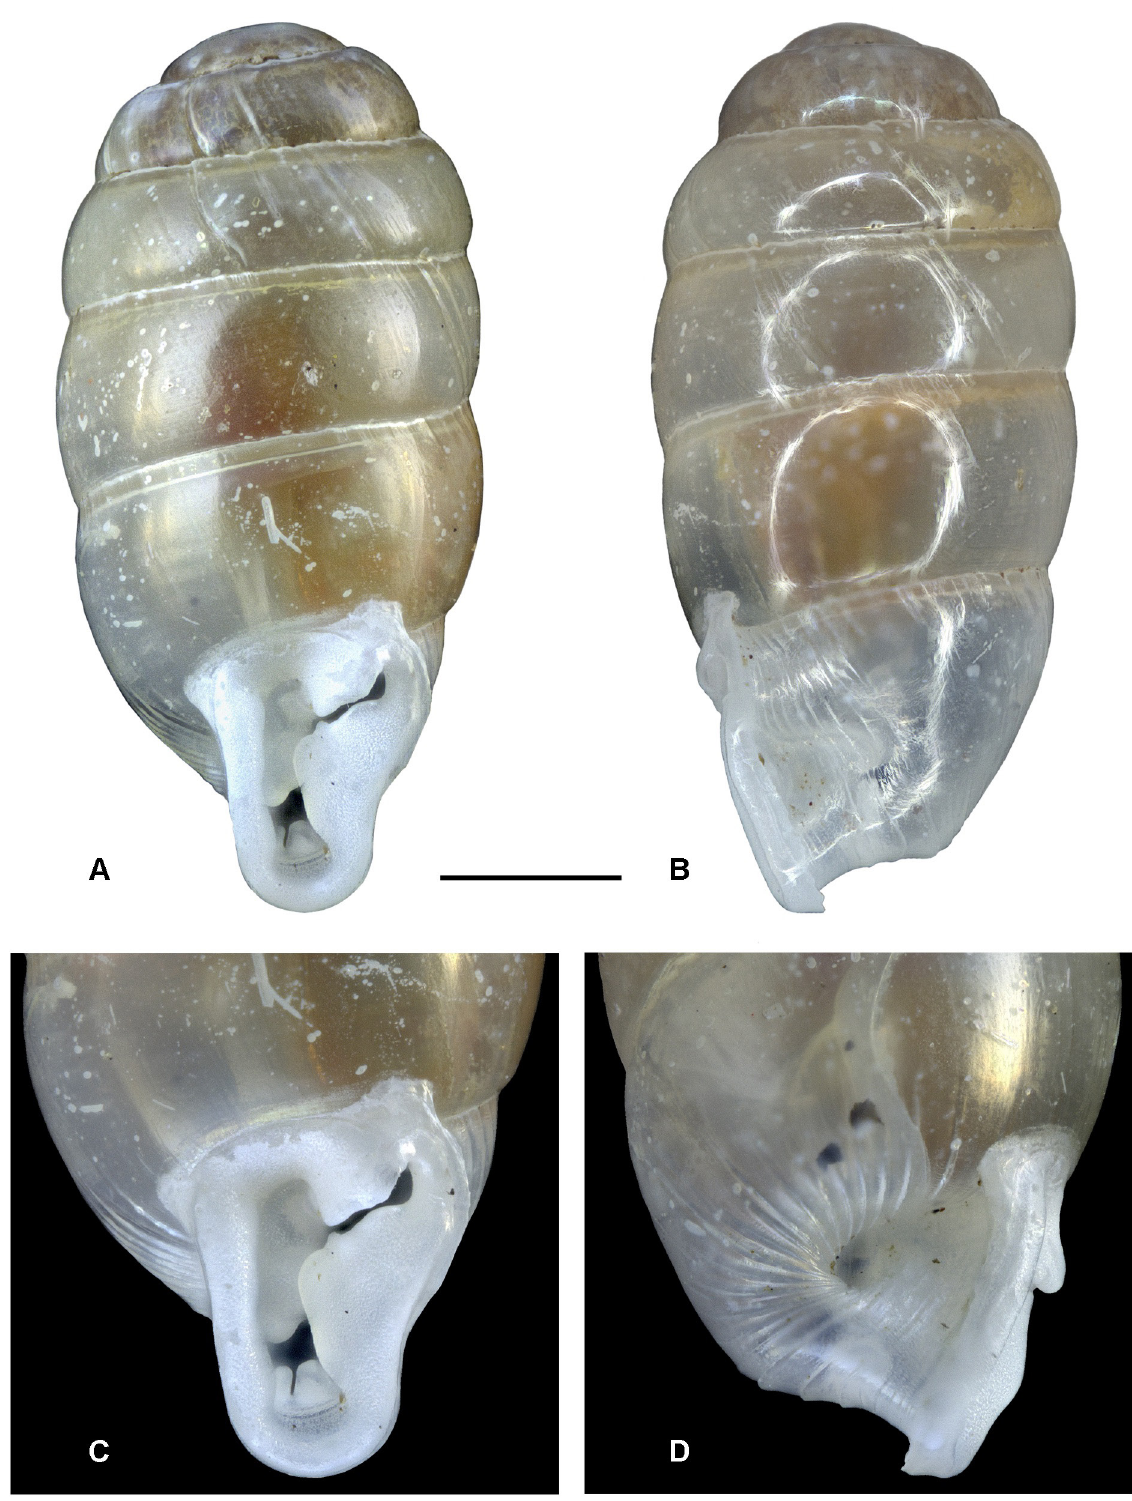
Fig. 7. Gulella crookesi sp. nov., holotype (NMSA P1680/T4526), length 2.44 mm, width 1.17 mm. A . Aperture view. B . Side view. C . View into aperture. D . Oblique view of base showing umbilicus. Scale bar = 0.5